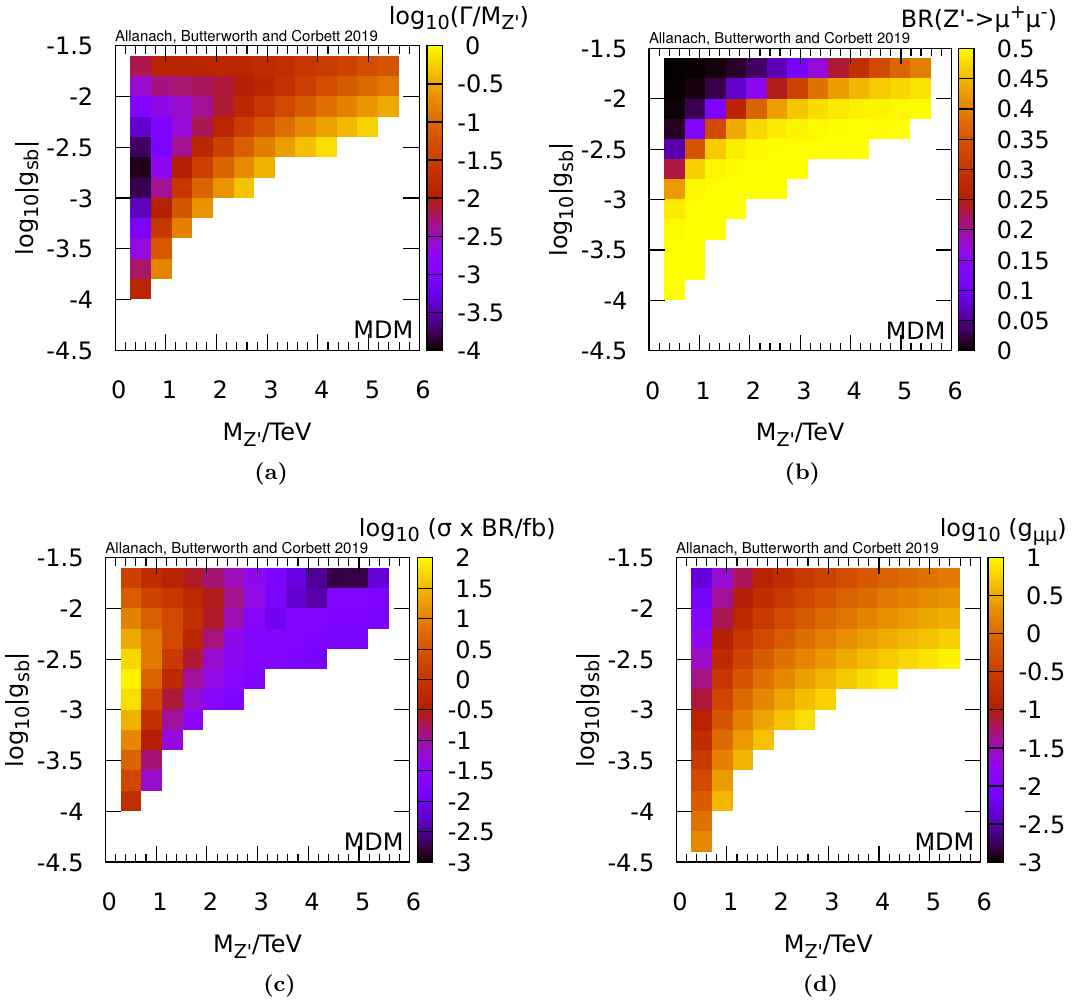
Figure 6 . Properties of the central (cid:12)t of the MDM model to NCBAs. In (a), we show the Z 0 width divided by its mass, (cid:0) =M Z 0 . In (b), the branching ratio into di-muons is shown, in (c) the (cid:12)ducial Z 0 production cross section multiplied by its branching ratio into di-muons is displayed. (d) shows g (cid:22)(cid:22) coming from the central (cid:12)t to NCBAs. The white region is non-perturbative.